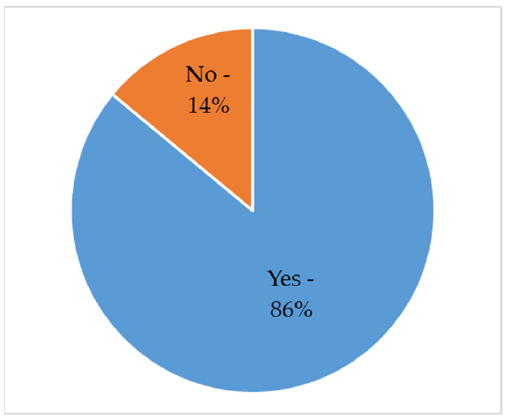
Figure 3. Selected survey results—an analytical–economic perspective: do you foresee that the province will provide financial support for the development of energy production from renewable sources (RES)?